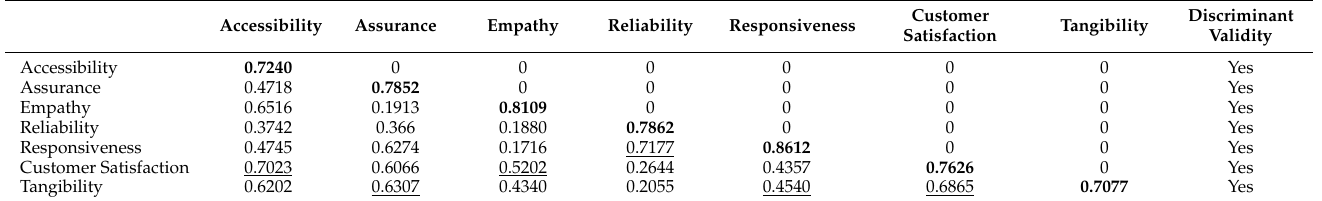
Table 3. Discriminant validity confirmation based on the Fornell–Larcker method (service quality).